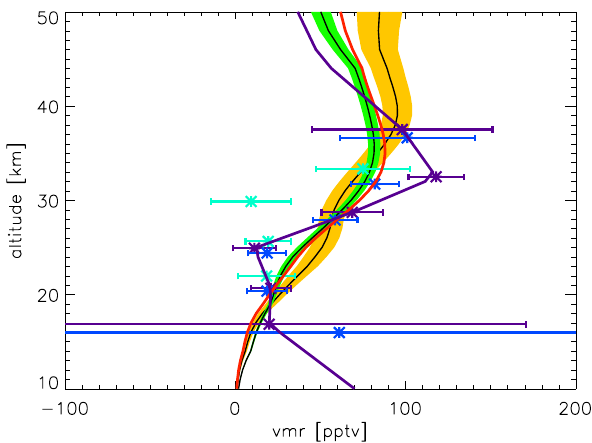
Fig. 7. Comparison of H 2 O 2 balloon-borne observations (Chance et al., 1996) (asterisks: September 1989; violet: afternoon; blue: night; light blue: morning) and MIPAS observations (yellow: September 2002; green: September 2003) all showing 1-sigma er- ror bars; balloon measurements were made above Fort Sumner (34.5 ◦ N), while MIPAS measurements are zonal means between 30 ◦ N and 40 ◦ N. The solid violet line is the interpolated balloon- borne profile, while the red line is the violet profile convolved with the MIPAS A